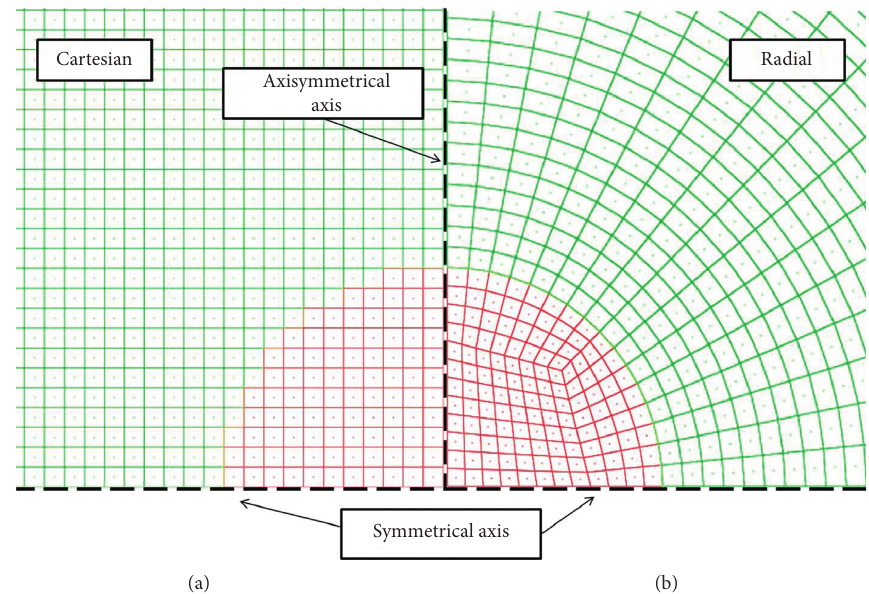
Figure 1: Cartesian (a) and radial (b) mesh structure for the numerical